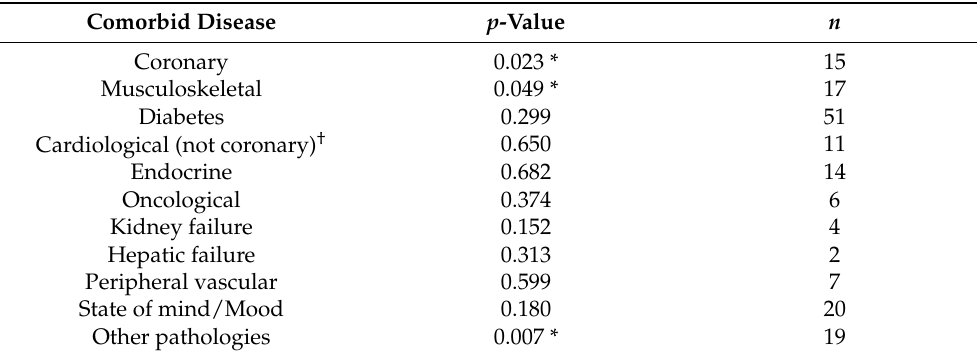
Table 5. Relation between sexual dysfunction and other